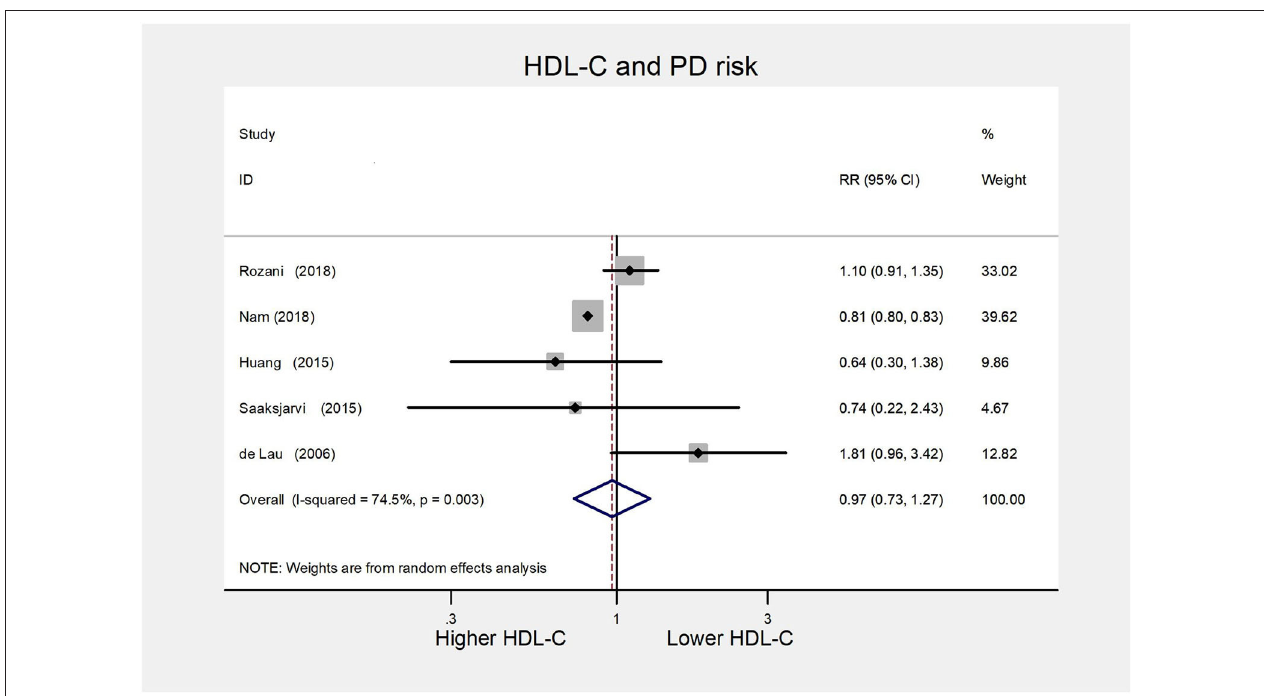
FIGURE 7 | Forest plot presenting the pooled estimate effects(RR) on the relationship between serum HDL-C levels and risk of PD. RR, relative risk; CI, confidence interval; HDL-C, high-density lipoprotein cholesterol; PD, Parkinson’s disease.